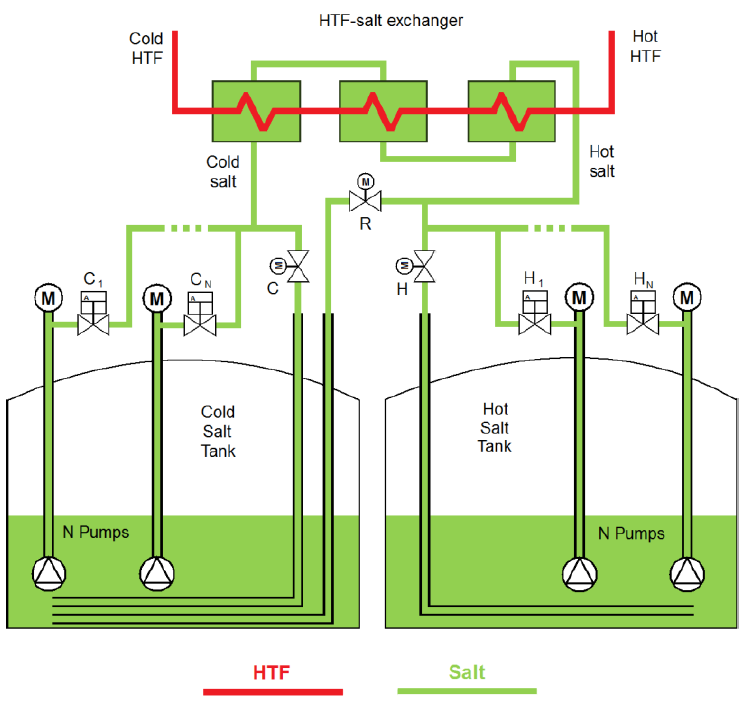
Figure 1. Schematic of a thermal energy storage (TES) system.